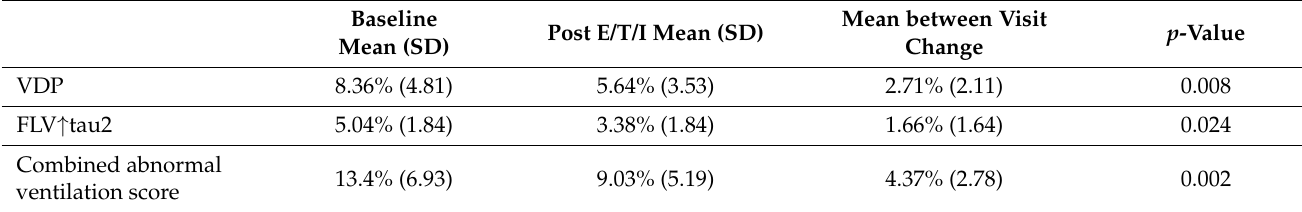
Table 4. Functional ventilation parameters before and after